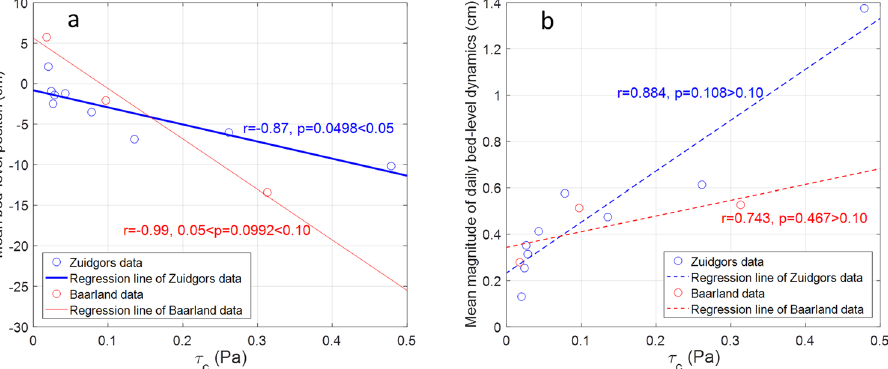
Figure 4. Correlation between τ c distribution and mean relative bed positon (plane a ), and correlation between τ c and the mean magnitude of daily bed-level dynamics (plane b ) at both sites. The data of the mean relative bed positons and the mean magnitude of daily bed-level dynamics is shown in the Fig. 3. The significant and marginally significant correlation is shown as thick solid line and thin solid line, respectively. The insignificant correlations are shown as dashed lines.